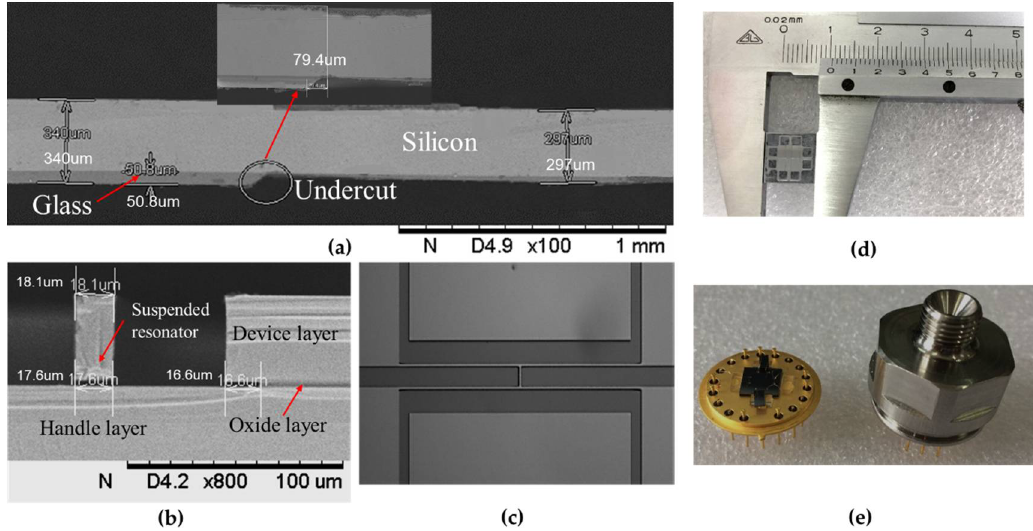
Figure 5. ( a ) The scanning electron microscopy (SEM) image of the cross section of the SOG cap; ( b ) Cross section of the suspended resonator with an undercut of 16.6 µ m on the anchor; ( c ) Image of the top view of the resonator; ( d ) Image of a prototype sensor with a dimension of 10 mm × 10 mm; ( e ) Image of packaged prototype of the resonant pressure micro sensor.